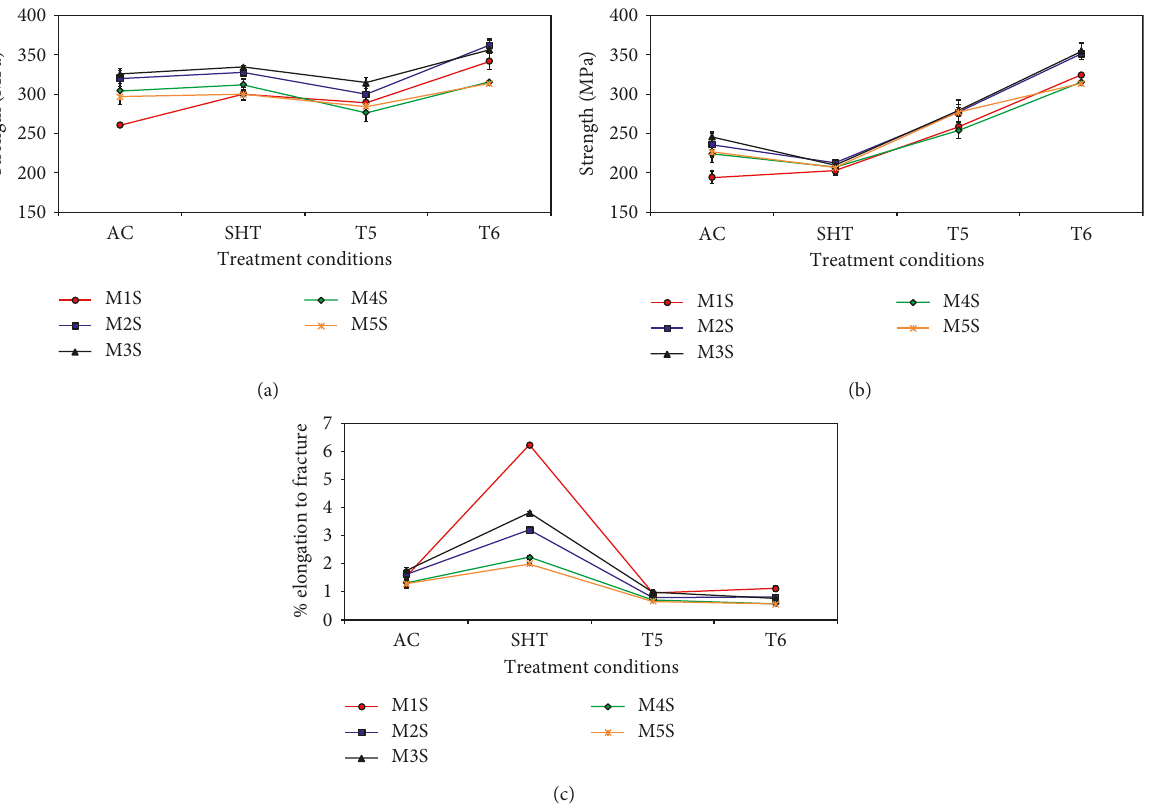
Figure 3: Variation in average (a) UTS, (b) YS, and (c) % El values of the alloys studied in as-cast, solution heat-treated (SHT), and T5- and T6-treated conditions obtained at ambient